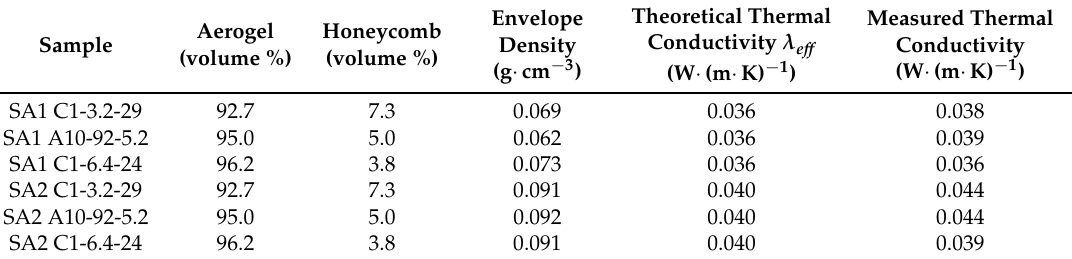
Table 2. Properties of produced honeycomb.